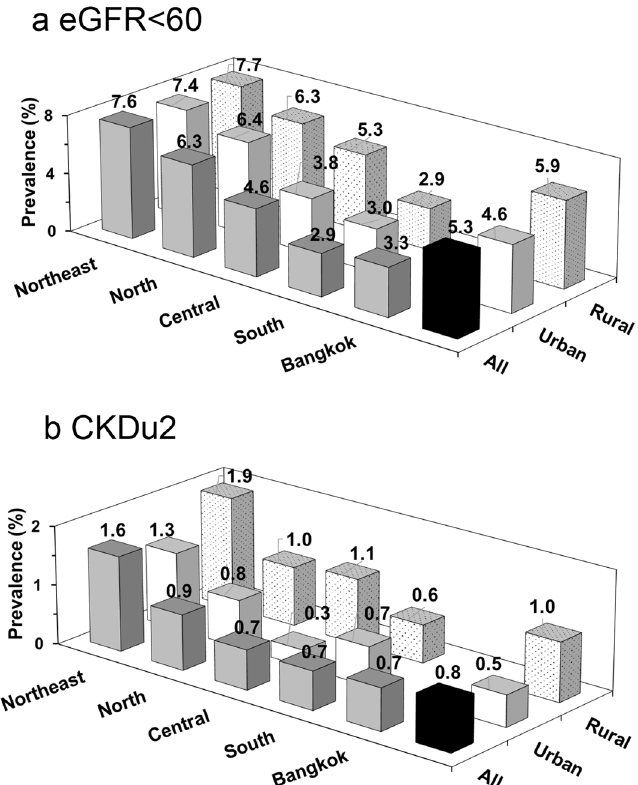
Figure 2. Regional and area distribution of ( a ) eGFR < 60; ( b ) CKDu2. Black column represents total population prevalence. Dark grey column represents combined areas (rural and urban) prevalence for each geographic region. ( a ) eGFR < 60 prevalence shown for all adults (Age ≥ 20): Northeast (n = 3704), North (n = 3896), Central (n = 4240), South (n = 3195), Bangkok (n = 2294). Light column represents urban area (n = 9090) and shaded column represents rural area (n = 8239). ( b ) CKDu2 prevalence shown for adults Age < 70: Northeast (n = 3059), North (n = 3202), Central (n = 3547), South (n = 2602), Bangkok (n = 2025). Light column represents urban area (n = 7684) and shaded column represents rural area (n = 6753).CKDu1 (not shown) has nearly identical distribution to CKDu2. Prevalence probability weighted for the registered 2014 Thai population stratified by age, sex, area of residence (urban/rural), and geographic